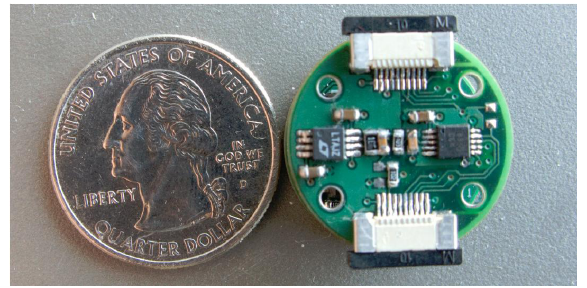
Figure 4. Capacitive electrodes proposed in